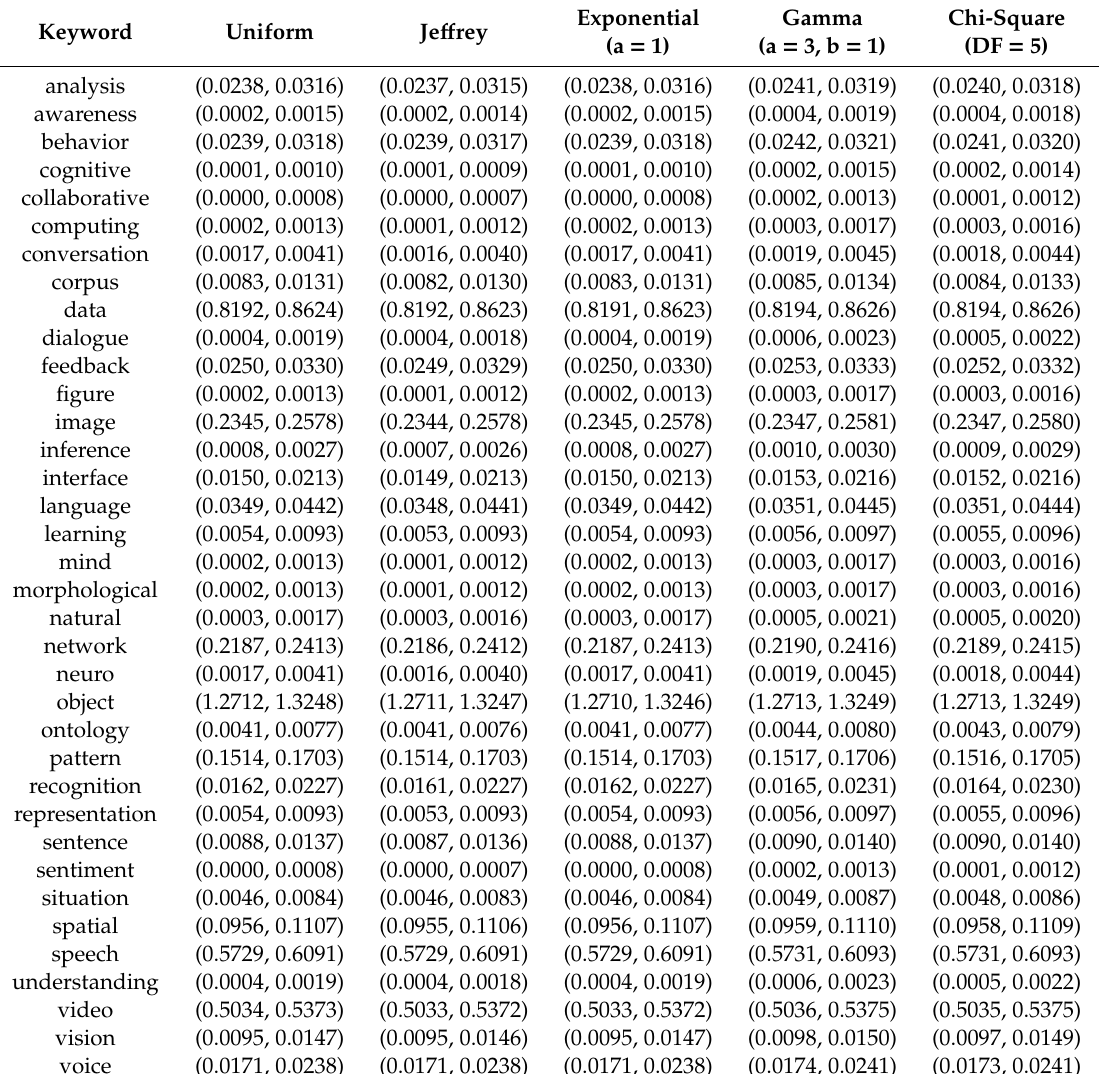
Table 5. Bayesian prediction intervals: